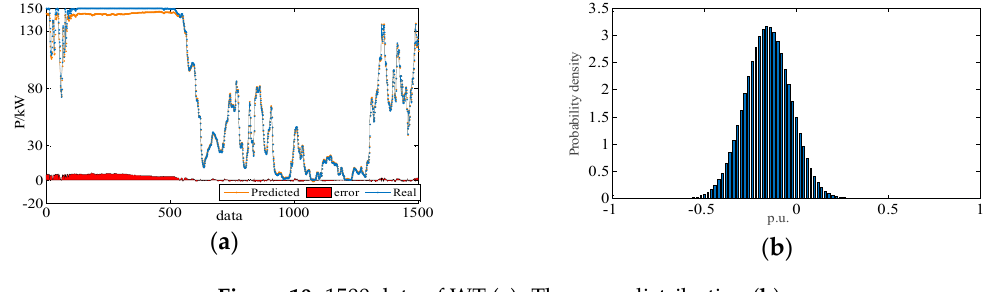
Figure 10. 1500 data of WT ( a ). The error distribution ( b ).